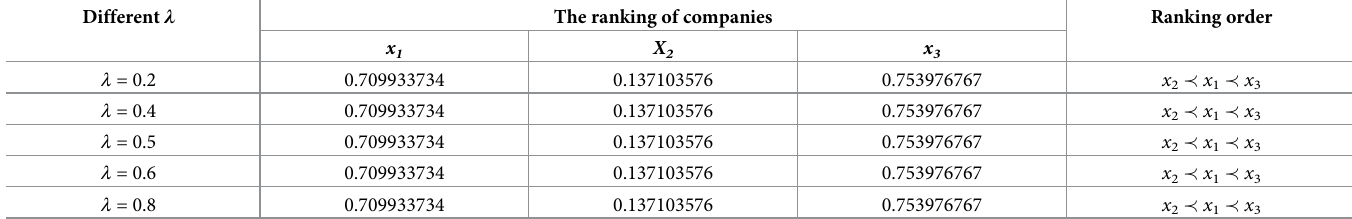
Table 14. Ranking order of companies with different λ . Different